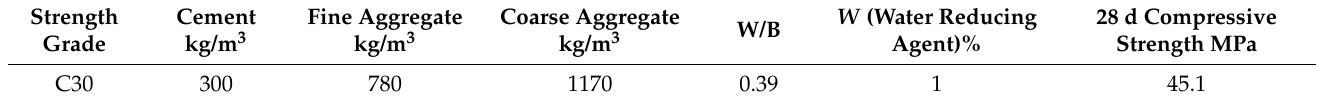
Table 2. Recycled concrete (RC) mixture ratio.